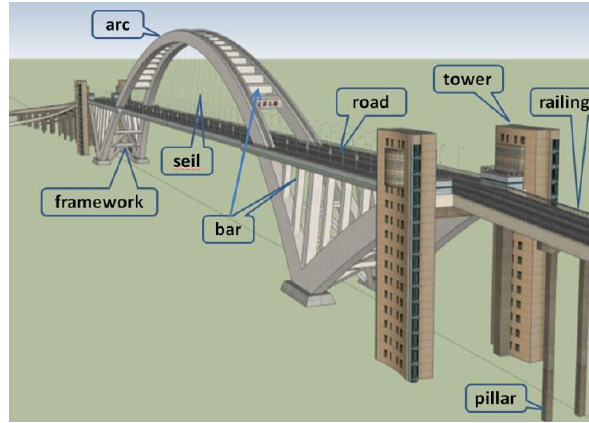
Figure 2. 3D model of the Lupu Bridge (©Google 3D Warehouse)